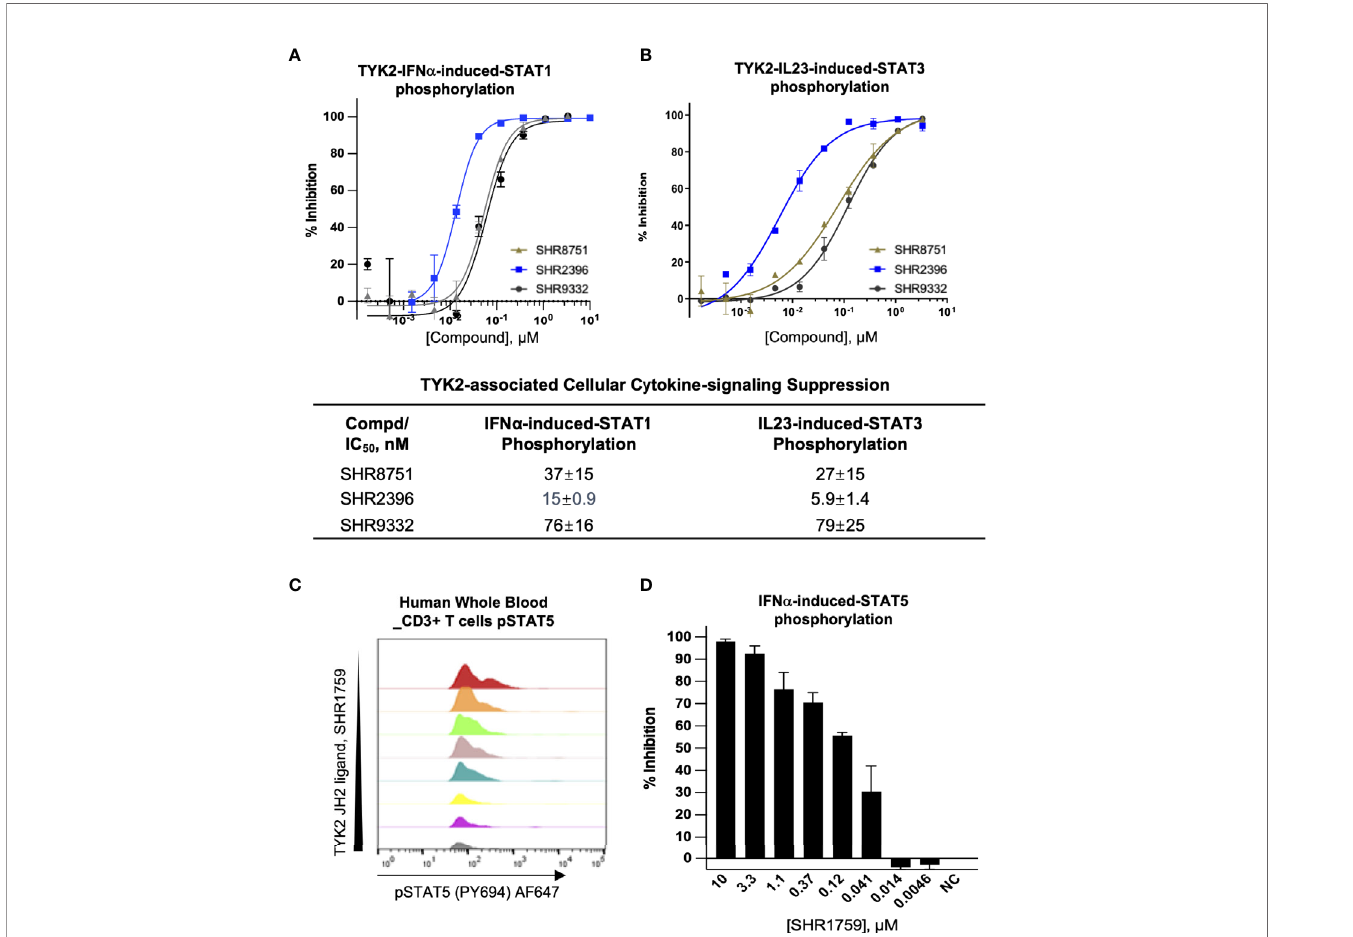
FIGURE 3 | Small molecule TYK2 pseudokinase ligands block IFN a - and IL23- mediated TYK2/STAT phosphorylation in human T cells. (A, B) Representative dose- response curves of TYK2 JH2 ligands, SHR8751, 2396 and 9332 on IFN a -induced phosphorylation (Tyr701) of STAT1 (A) and IL23-induced phosphorylation (Tyr705) of STAT3 (B) in Kit225 cells. Cells were seeded in 384-well plate at 1×10 5 cells/well and treated with serially diluted compounds (30 m M, 1:3) for 1 hour and stimulated with human recombinant IFN a or IL23 for 20 minutes. The treated cells were then lysed and cellular phosphorylated-STAT1 (Tyr701) or STAT3 (Tyr705) levels were measured by AlphaLISA; Inhibition data were calculated by comparison to vehicle control wells for 0% inhibition and non-stimulated control wells for 100% inhibition. Dose response curves were generated to determine the concentration required to suppress 50% of cellular response (IC 50 ) as derived by non-linear regression analysis using GraphPad Prism. Con fi rmatory studies were performed for the compounds. The fi gures are representative of three independent experiments with duplicates performed for each experiment unless stated otherwise. The average IC 50 values and standard deviations of each compound from three independent experiments are calculated and summarized in the table. (C, D) Suppression of STAT5 phosphorylation in human CD3+ T cells by a TYK2 JH2 ligand, SHR1759. After 1hour incubation with serially diluted compounds, human whole blood samples were stimulated with recombinant human IFN a for 15 minutes and then lysed for removal of red blood cells, fi xed, and permeabilized. White blood cells were stained with anti-CD3 FITC antibody, AF647 anti-Stat5 (pY694) antibody and later analyzed by fl ow cytometry. (C) Representative histogram of AF647 showed that IFN a -induced phosphorylation of STAT5 (Tyr694) in CD3+ T cells of human whole blood was suppressed by SHR1759 in a dose-dependent manner; (D) After gating on the CD3-positive population, the phosphorylation of cellular STAT5 in each treatment condition was quantitated by median fl uorescence intensity (MFI). Inhibition data were calculated by comparison to vehicle control wells for 0% inhibition and non-stimulated control wells for 100% inhibition. Each bar represents the % inhibition at indicated compound concentration. Con fi rmatory studies were performed for the compounds. The fi gures are representative of two independent experiments with duplicates performed for each